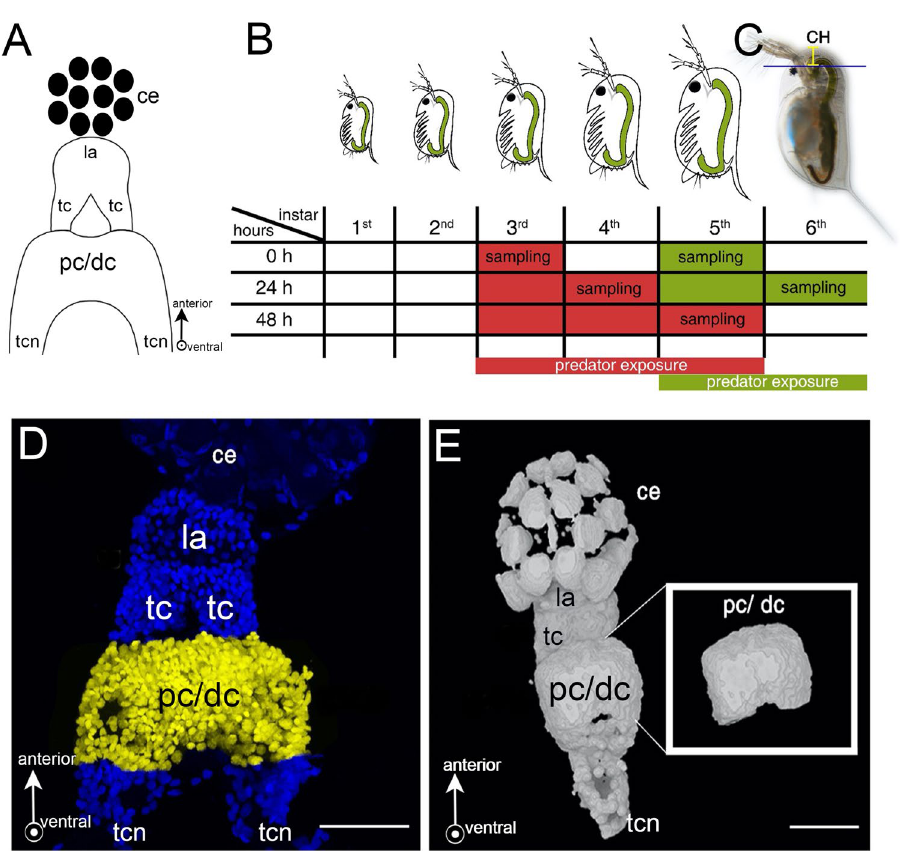
Figure 1. Schematic overview of experimental procedures. ( A ) Schematic frontal view of a Daphnia brain displaying the optic ganglia: composed of lamina and tecta, and pc/dc-complex. ( B ) Points in time of D. longicephala induction. Predator exposure started in the 3rd or 5th instar, respectively. When exposed in the 3rd instar, individuals were sampled at 0 h, 24 h and 48 h. To validate our findings in a different instar, animals were also exposed in the 5th instar; here we focussed on the target stages i.e. 0 h and 24 h. Controls were performed alongside the respective treatment but without predators. ( C ) Measurement of morphological defence parameters. We measured the crest height as the distance between the upper eye margin and the rostral extension of the head (yellow line). ( D ) Dissected brain mount stained with DAPI. We counted the cells of the pc/dc-complex (yellow). ( E ) 3D projection of a brain mount from confocal stacks for volumetrics created with MorphoGraphX Version 1.1.1280-CellAtlas (available from https:// www. mpipz. mpg. de/ Morph oGrap hX/ softw are). Only the pc/dc-complex (insert) was used to determine the brain volumes. ( A , D , E ) Arrows depict the anterior and ventral (arrow points out of the drawing pane) orientation. Abbreviations: CH, crest height; ce, compound eye; la, lamina; tc: tecta, pc/dc, pc/dc-complex; tcn, tritocerbral